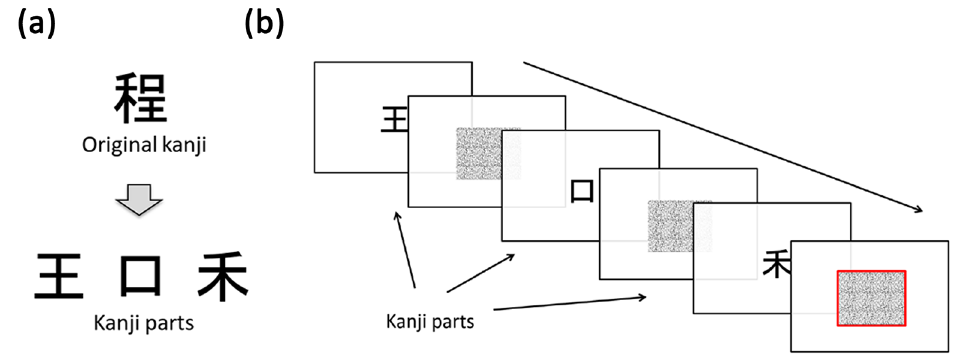
Fig 1. Experimental stimuli and sequence. (a) An example of an original kanji and kanji parts. Usually, kanji are made up of a number of commonly used parts. (b) Time sequence of the construction task in Experiment